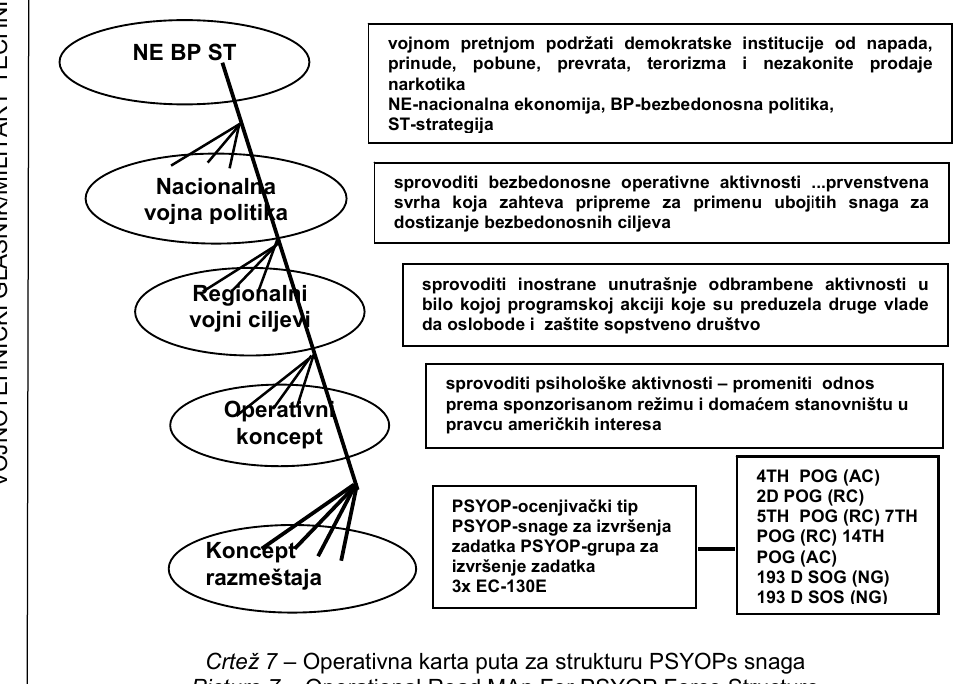
Picture 7 – Operational Road MAp For PSYOP Force Structure (Lewis, Roll, 1993,